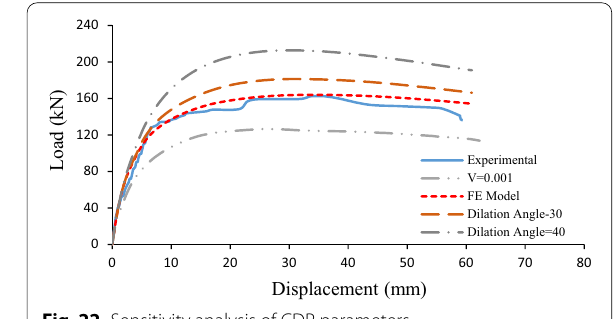
Fig. 22 Sensitivity analysis of CDP parameters.